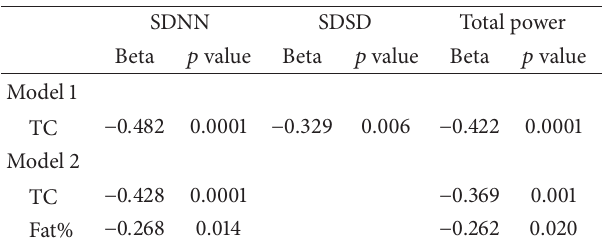
Table 6: Stepwise multivariate regression analysis of the indices of HRV with independent